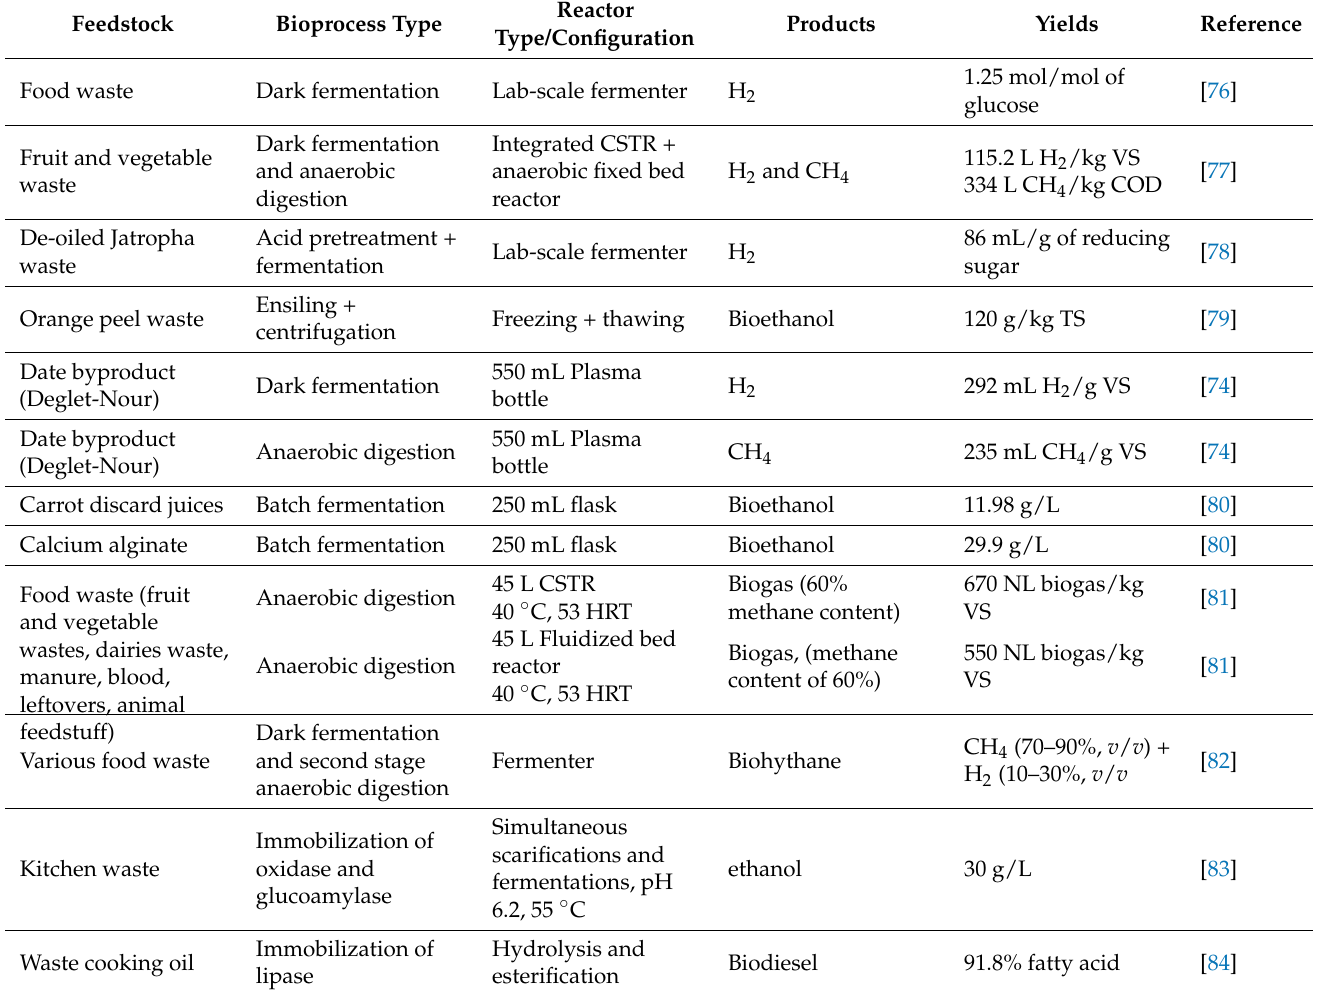
Table 2. Production of biofuel from food waste biorefinery